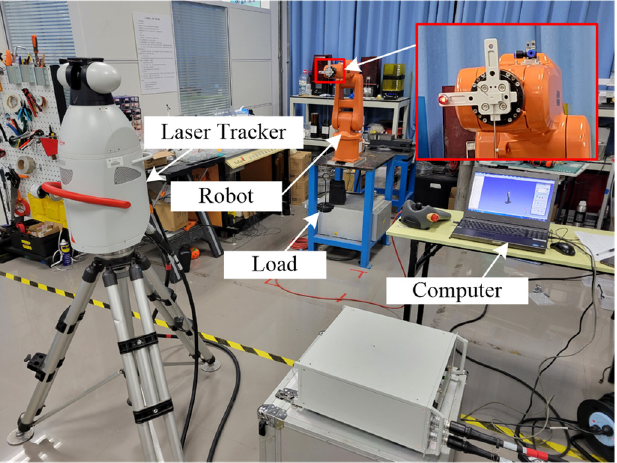
Figure 5. The experimental setup.